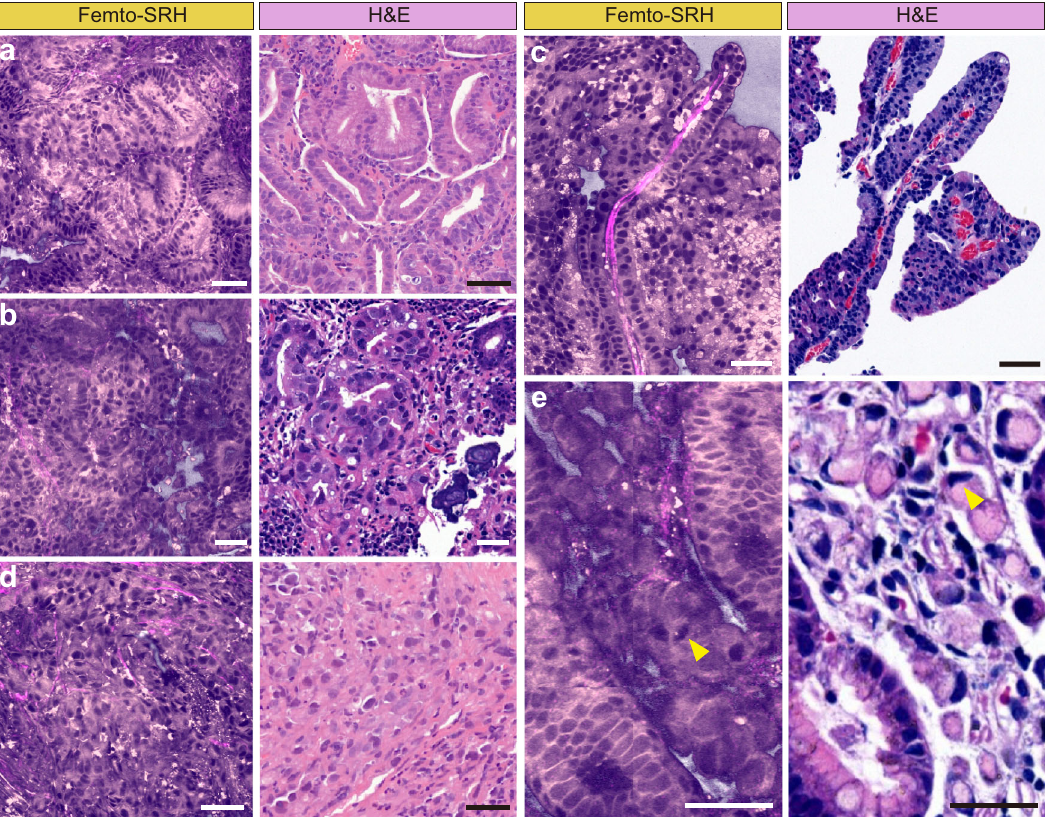
Fig. 4 Characteristic femto-SRH images of neoplastic fresh gastroscopic biopsies. Differentiated carcinomas include: ( a ) well-differentiated adenocarcinoma, ( b ) moderately differentiated tubular adenocarcinoma, and ( c ) differentiated papillary adenocarcinoma with fi brovascular connective tissue cores. Undifferentiated carcinomas include: ( d ) poorly differentiated adenocarcinoma, and ( e ) signet ring cell (arrowheads) carcinoma. Scale bars: 50 µ m. Source data are provided in the Source data fi